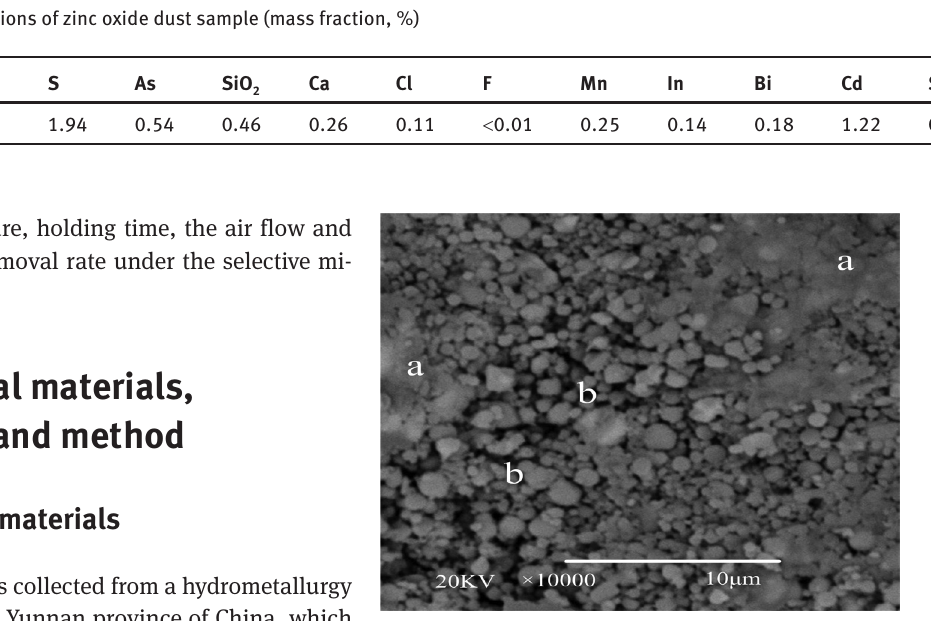
Fig. 1: SEM image of zinc oxide dust sample